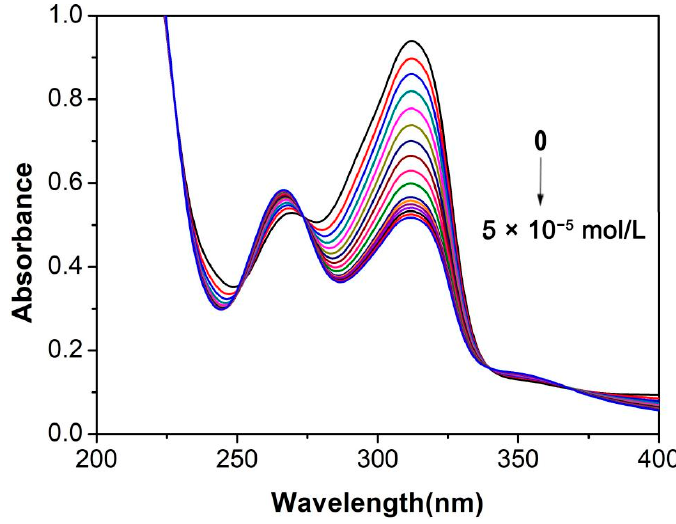
Figure 3. UV-Vis spectra of L (50 μ mol/L) with increasing amounts of ZnCl 2 (0–3 equiv.).